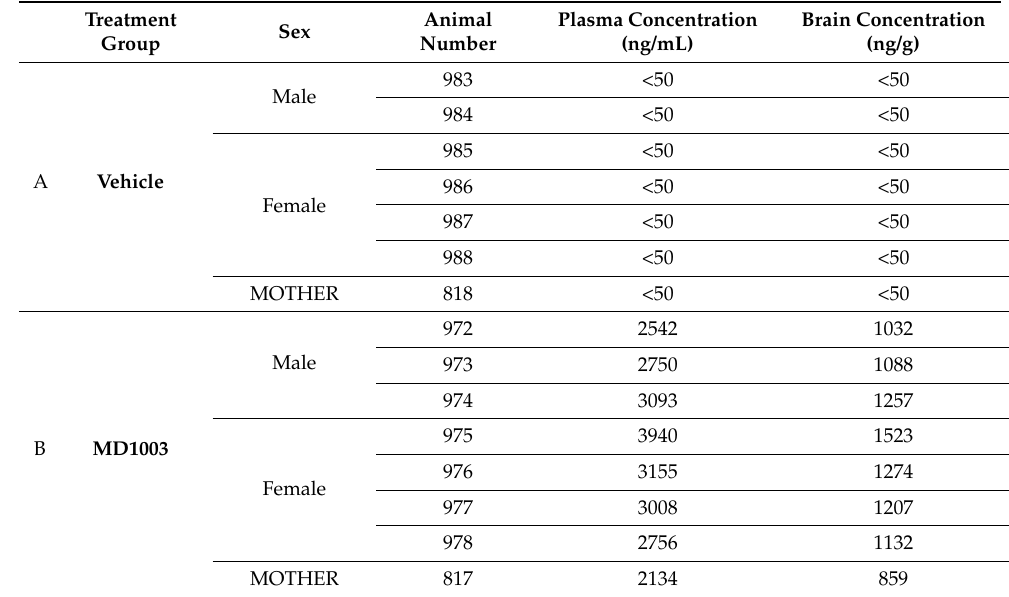
Table 1. Determination of MD1003 concentration in plasma (ng/mL) and in brains (ng/g) of P14 pups following administration of (A) vehicle and (B) MD1003 food to